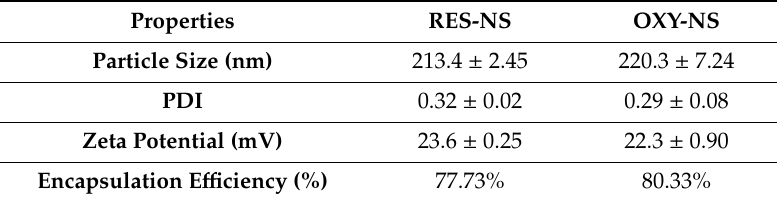
Table 1. Physicochemical properties of RES-NS and OXY-NSs.